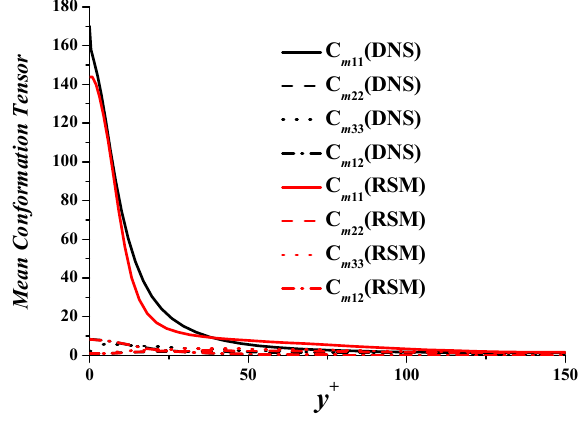
Figure 4. Stress balance.